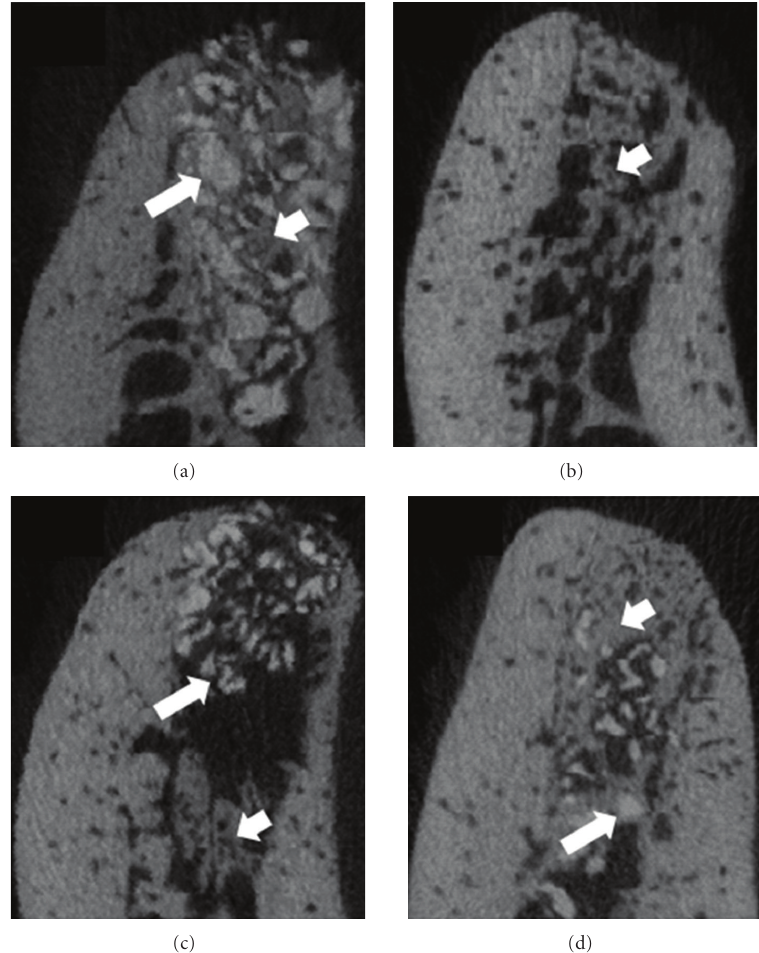
Figure 3: Enlarged representative images of µ CT slices within the middle of the distal root, 4th premolar extraction sockets after the six-week healing time. (a) Bovine xenograft particulate and collagen plug (X), (b) bone putty only (Bp), (c) xenograft particles sandwiched between layers of bone putty placed in the coronal and apical aspect (Bp-X-Bp), and (d) a 3:1 mixture by weight of bone putty and xenograft particles, respectively (3Bp-X). Residual xenograft particles (appearing denser than the surround bone) can be seen in within the extraction sockets in panels (a), (c), and (d) (long arrows) interspersed between newly formed bone (short arrows,